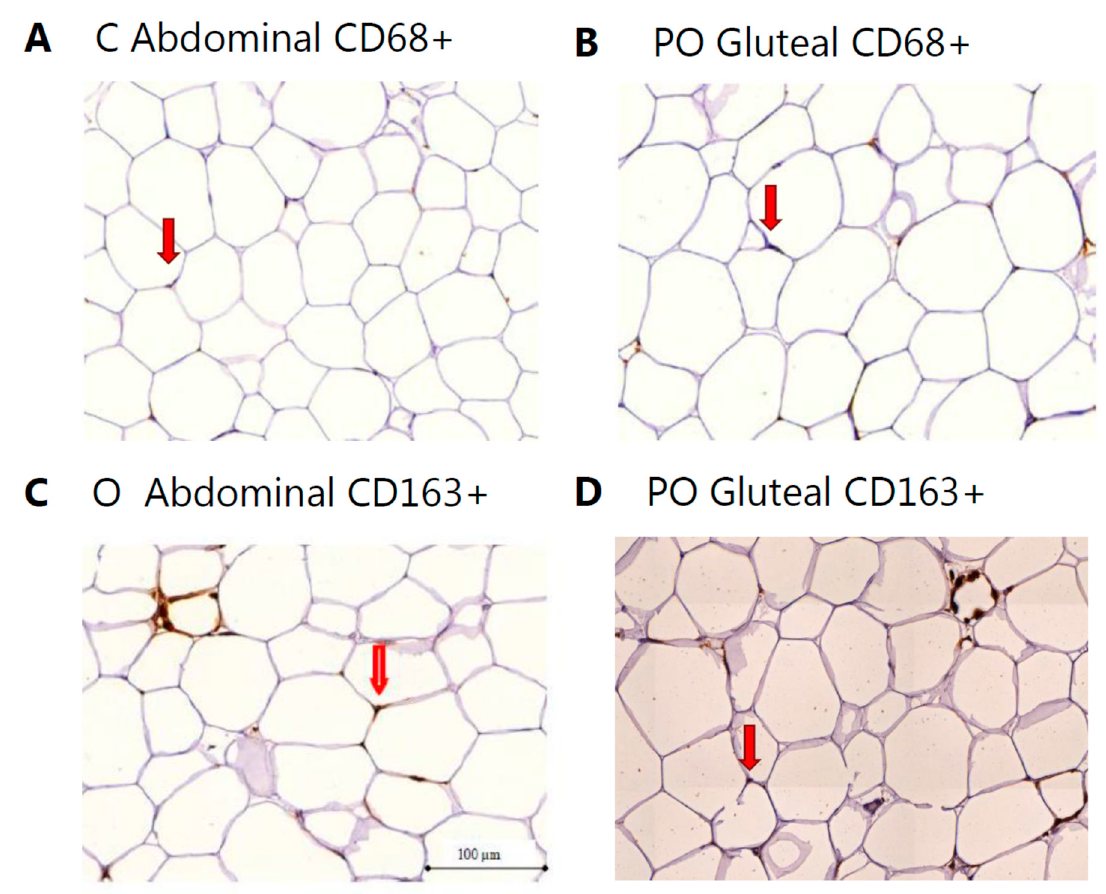
Figure 1. Representative images of macrophage infiltration in different subjects from PO, O, and C of CD68 + ( a , b ) and CD163 + ( c , d ) cells in subcutaneous abdominal and gluteal adipose tissue depots, respectively. The red arrows point to a positive staining of the corresponding marker.